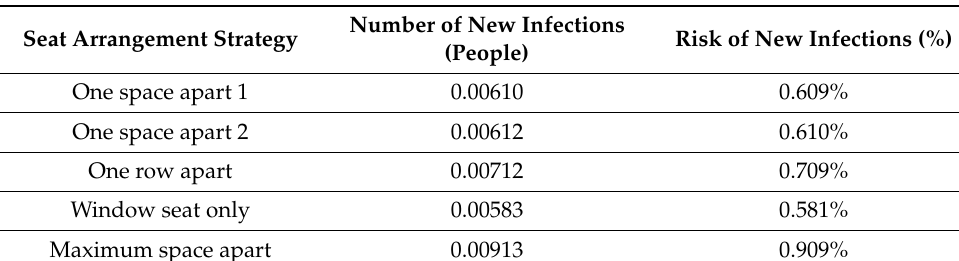
Table 3. Number and risk of new infections by seat arrangement strategy.